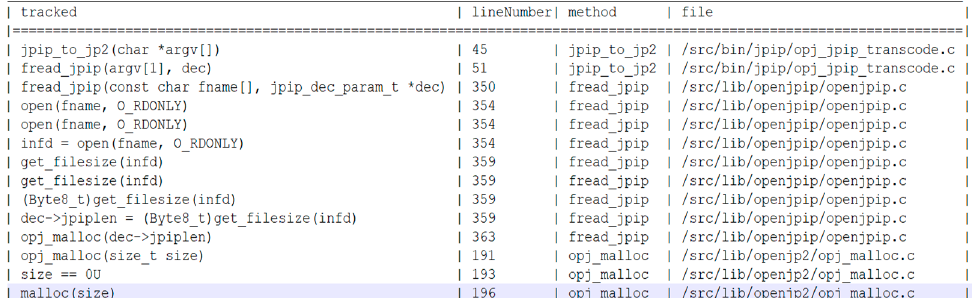
Figure 4. OpenJPEG v2.3.0 partial data flow path.